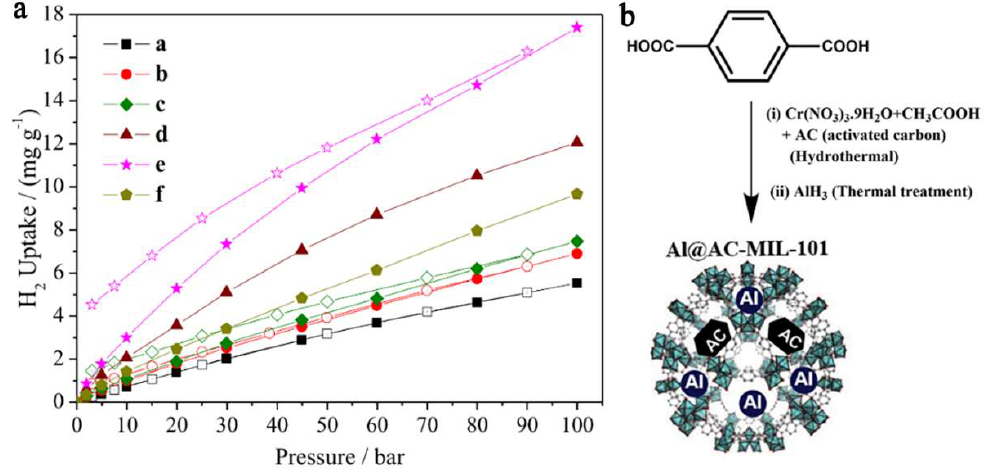
Figure 14. Hydrogen adsorption–desorption isotherms for (a) MIL-101; (b) AC-MIL-101; (c) AL@MIL-101; (d) Al@AC-MIL-101-A; (e) Al@AC-MIL-101-B; (f) Al@AC-MIL-101-C at 298K and pressures up to 100 bar H 2 (closed symbols-Adsorption; open symbols: Desorption) ( a ). AlH 3 introduction into MIL = 101 ( b ). Reprinted/adapted with permission from Ref. [40]. 2017, Elsevier Inc.